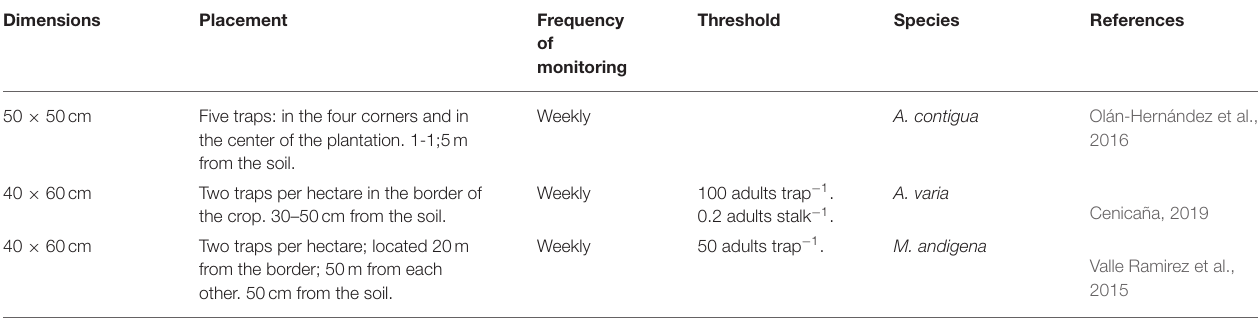
TABLE 3 | Yellow sticky traps: dimension and action threshold by spittlebug species.